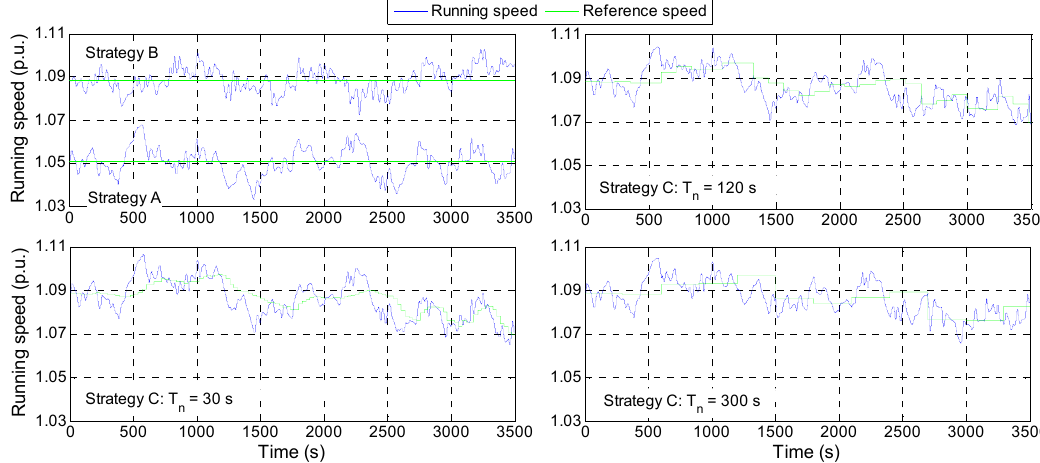
Figure 8. Running speed and reference speed with the three strategies. Long penstock configuration, p 0 = 0.7 p.u., h c0 = 1.131 p.u., scenario 1.